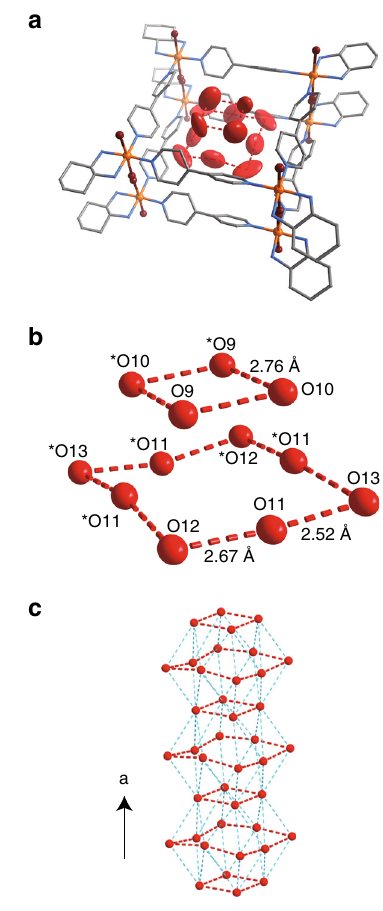
Fig. 2 Water-cluster formation within channel A (100K). The results of SCXRD are displayed. a ORTEP drawing (30% probability ellipsoids) of the 12 unique oxygen atoms in the nanotube. b Tetramer and octamer-like water clusters. The red dotted line represents the hydrogen bonds. c 1D hydrogen-bonding network of water clusters. Light blue dotted line represents the hydrogen bonds between water